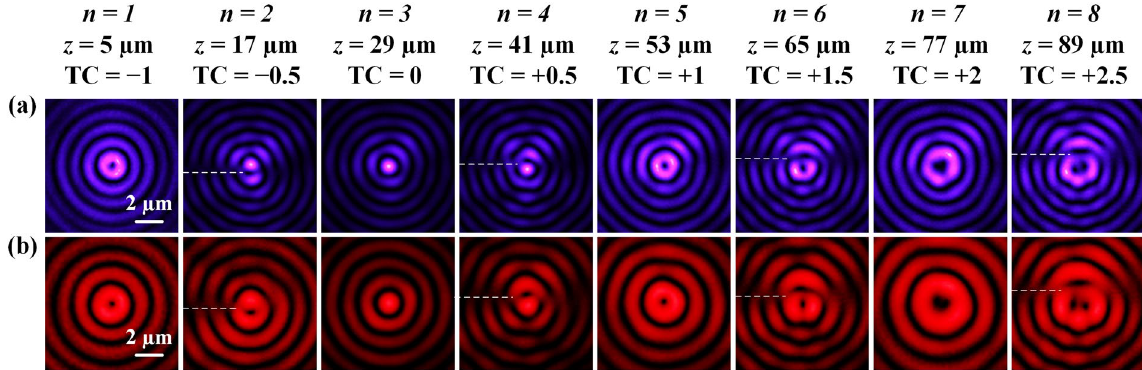
Figure 5. Measured beam intensity distributions for the OAM transformation process at different z ( n ) at ( a ) 405 nm and ( b ) 633 nm. The white dashed lines mark the dislocation cut lines of fractional-order